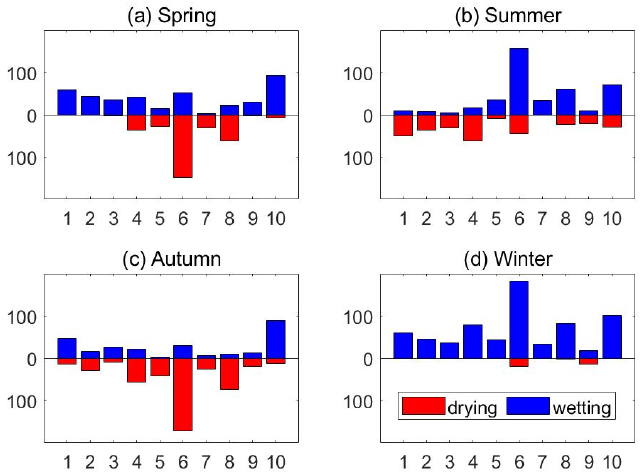
Figure 4. Number of drying / wetting climate stations in spring ( a ), summer ( b ), autumn ( c ), and winter (d) from 1961–1988 to 1989–2016 within the ten basins. On the x-axis, 1~10 represent the basins of Songhuajiang (1), Liao River (2), Hai River (3), Yellow River (4), Huai River (5), Yangtze River (6), Southeast (7), Pearl River (8), Southwest (9), and Northwest (10), respectively. Water 2020 , 12 , x FOR PEER REVIEW